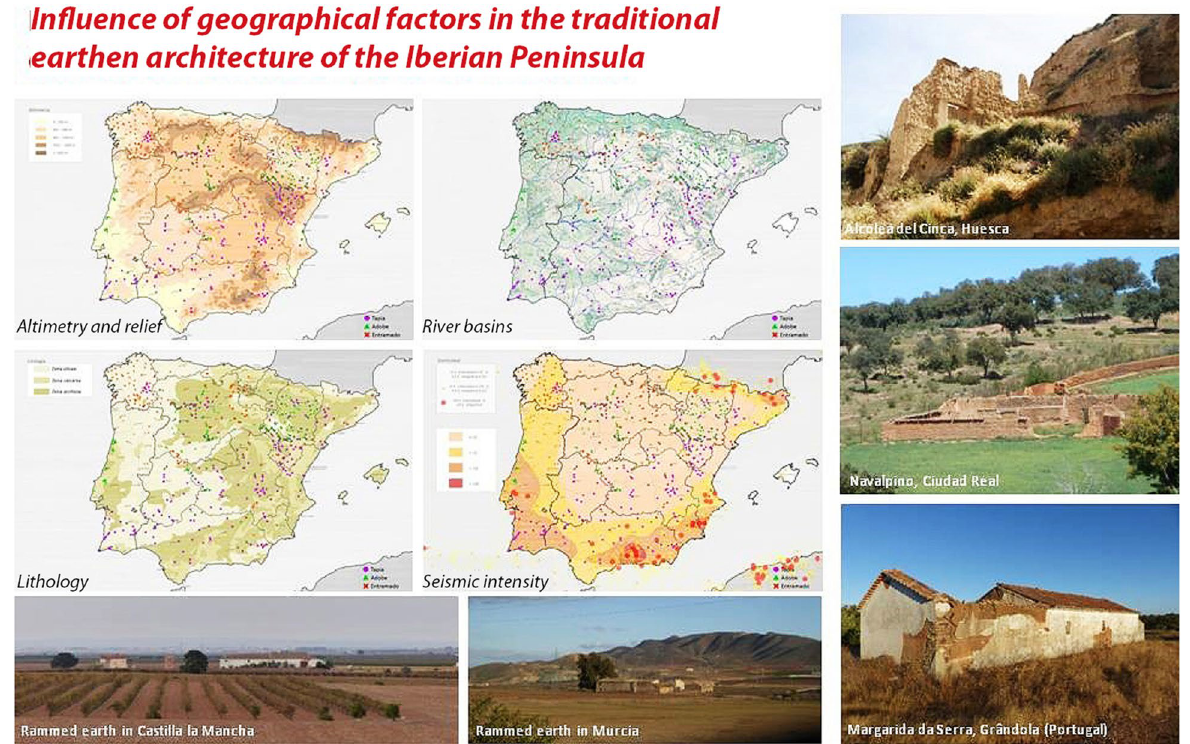
Fig. 3 Mapping of geographical factors that can influence the distribution of earthen constructive techniques (Source: RES‑TAPIA & SOS‑TIERRA